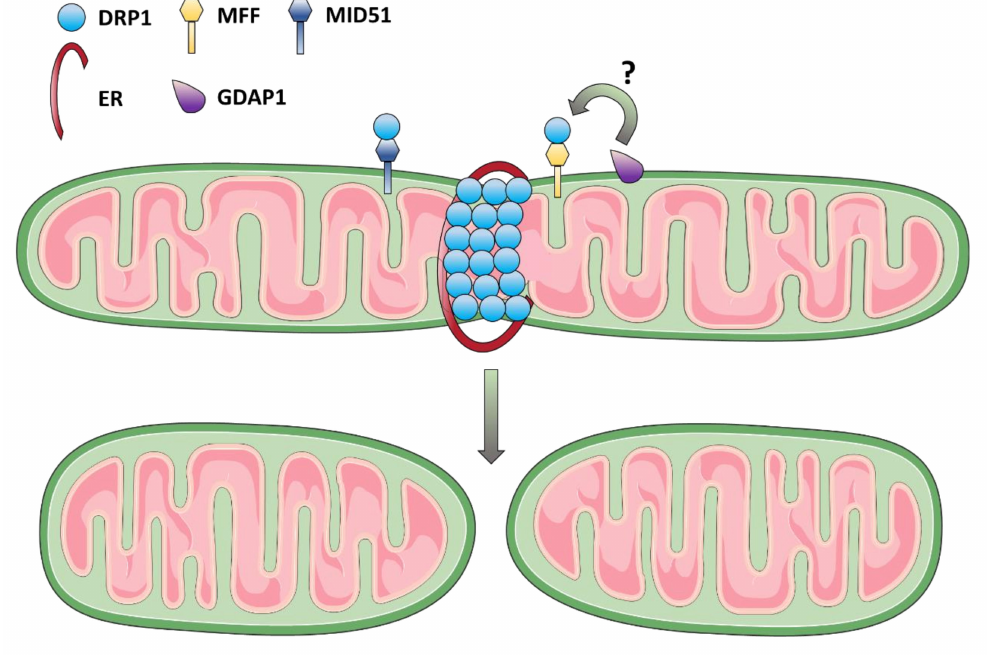
Figure 3. Proteins regulating mitochondrial fission and associated with optic atrophy. A graphical representation of the fission process, where the proteins involved in the degeneration of optic nerve are shown (see also Table